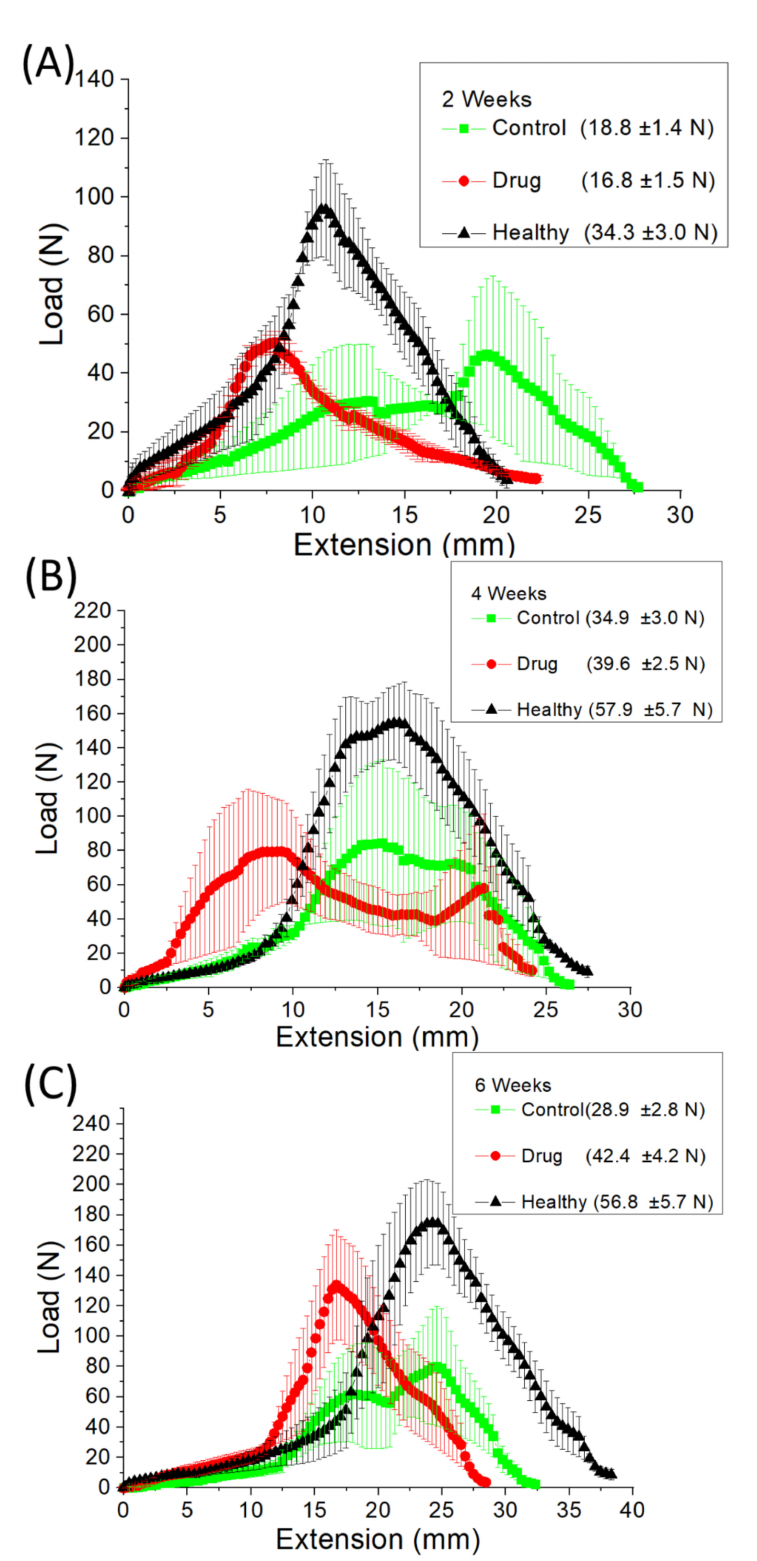
Figure 5. Tendon strengths at ( A ) 2, ( B ) 4, and ( C ) 6 weeks post-surgery in the healthy, doxycycline- loaded, and control (surgery only, no membrane)